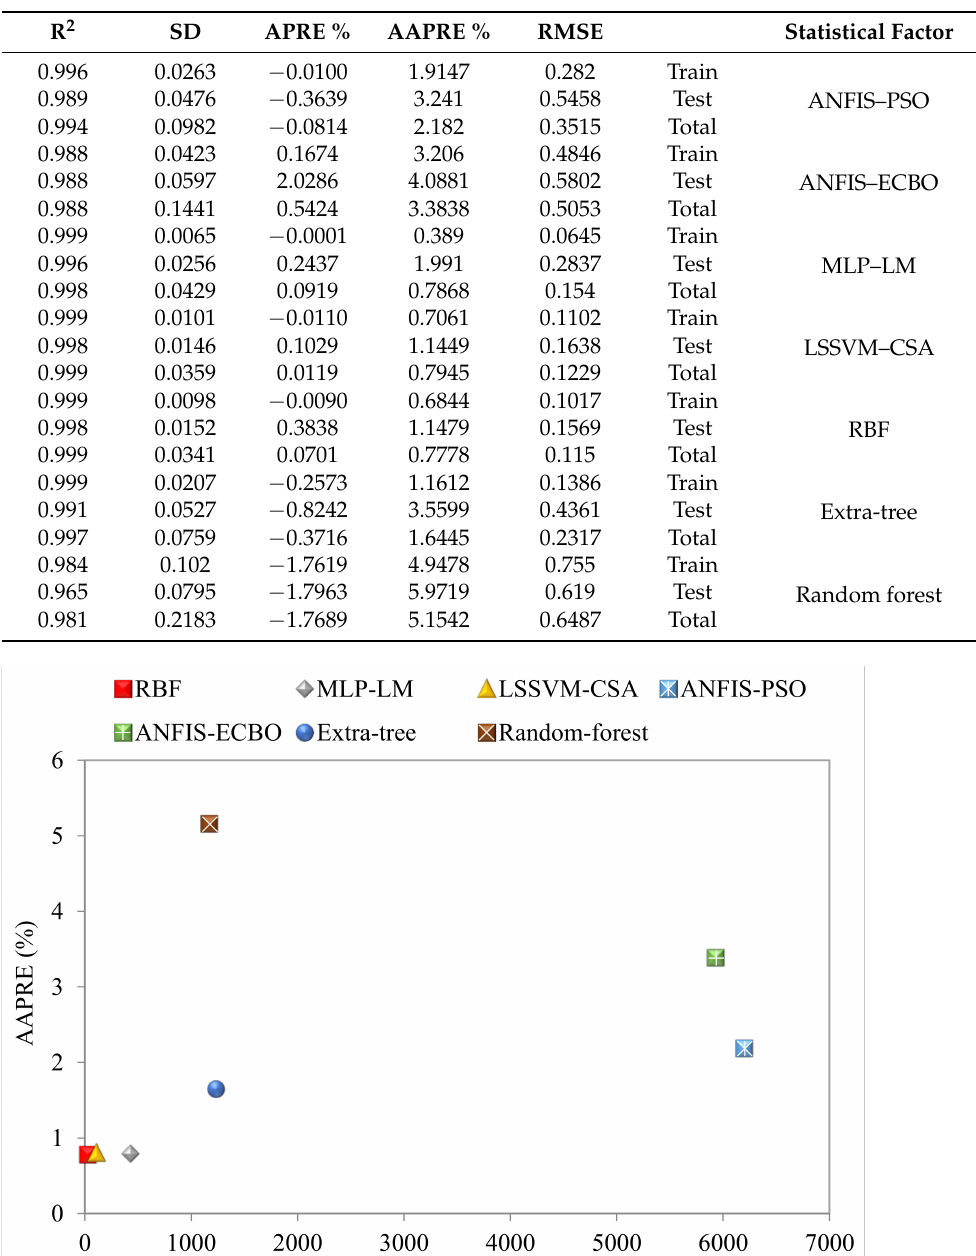
Table 2. Statistical parameters for the proposed models in this work.